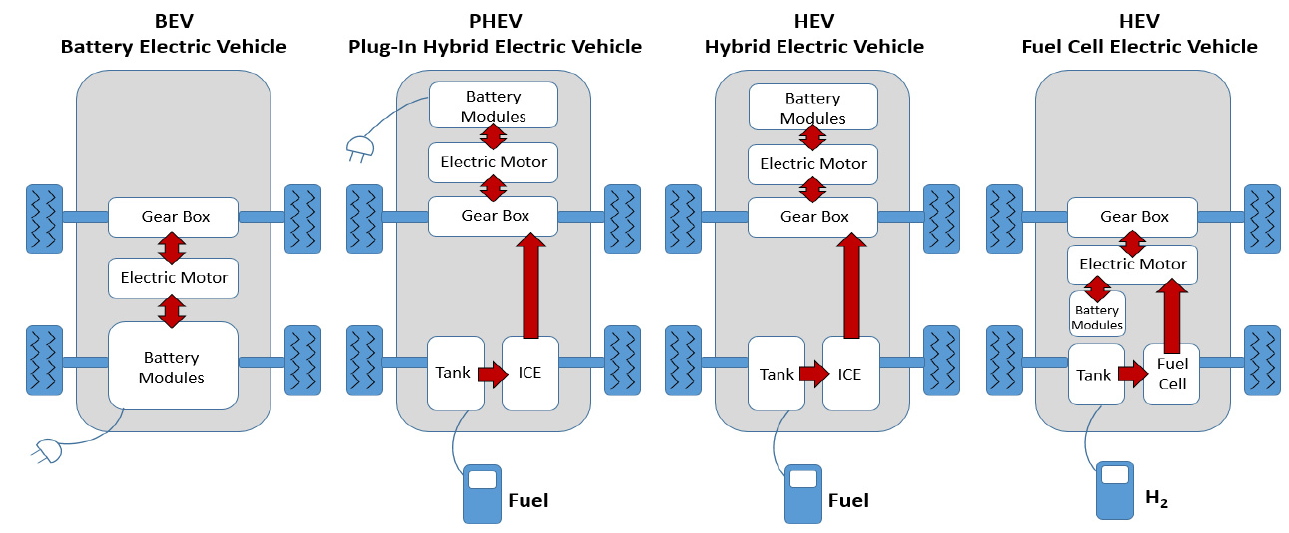
Figure 1. Types of commercially available EVs today.